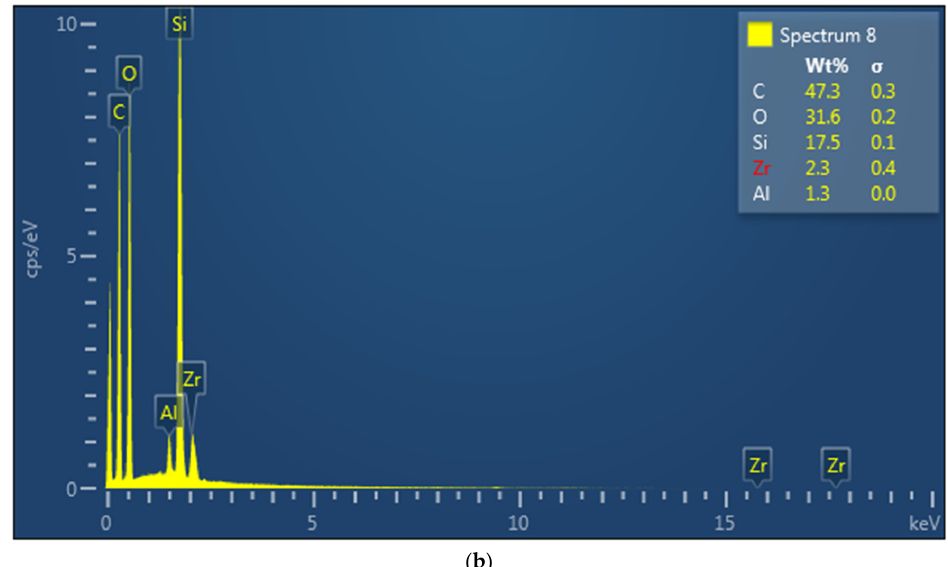
Polymers 2021 , 13 , x FOR PEER REVIEW Figure 2. ( a ): Electron image of the bioactive cement, Ceramir. ( b ) : EDX for Ceramir showing Al, Si, and O from the aluminate (Al) and glass (Si-Zr) powder in the filler and other oxides (O).